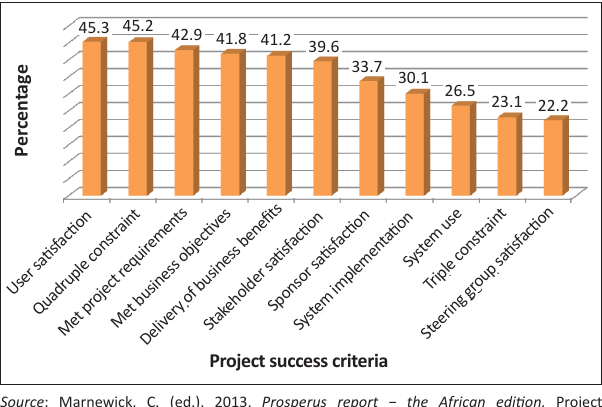
FIGURE 2: Information technology related project success